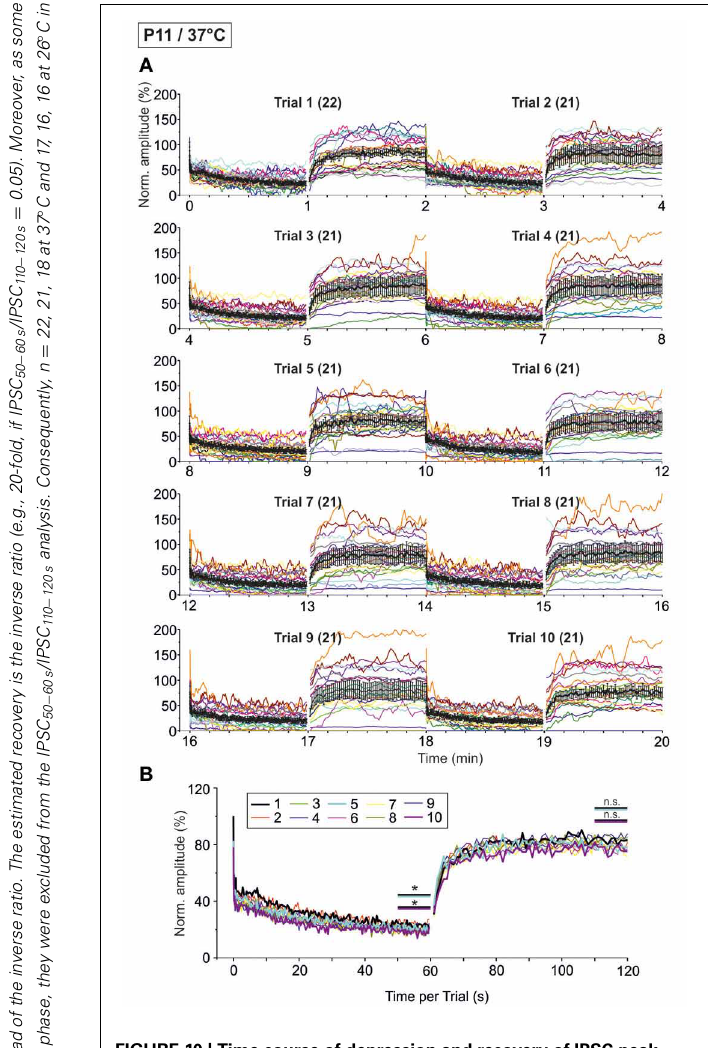
FIGURE 10 | Time course of depression and recovery of IPSC peak amplitudes at P11/37 ◦ C upon very prolonged stimulation, lasting 20min (cf. Figure 1B 2 ). Ten trials of 50 and 1Hz/60s episodes were applied (Trial 1–10), amounting to a total of 30,600 stimuli. (A) Time course of the IPSC peak amplitudes (one color per neuron, n = 21–22). Mean values ± s.e.m. are shown in black (simple moving average of five data points). Due to the smoothing, failures are no longer discernable. (B) Superposition of the ten averaged time courses, illustrating the similarities across trials (traces for trials 1, 5, and 10 are highlighted by a thick black, turquoise, and magenta line, respectively). Statistical comparison was done between trials 1 and 5 and trails 1 and 10. ∗ p < 0 .